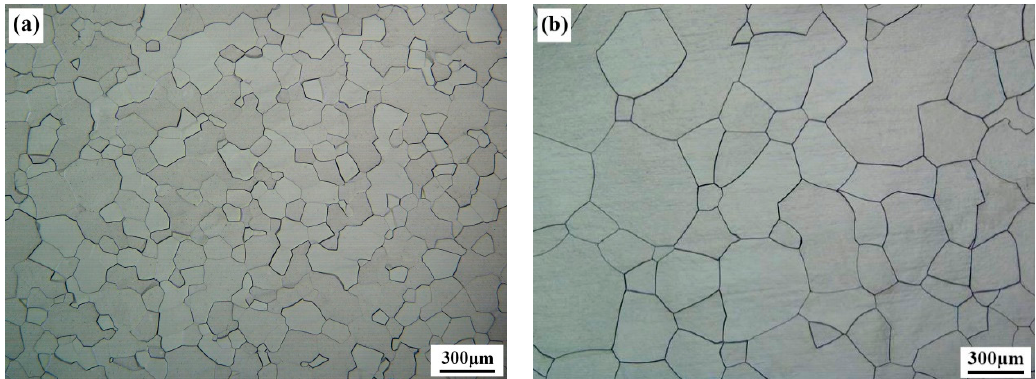
Figure 2. OM image of the initial water-quenched microstructure of the Ti–3.5Al–5Mo–4V alloy formed by a matrix of metastable β grains of approximately equiaxed morphology. ( a ) 850 °C and ( b ) 1050 °C.